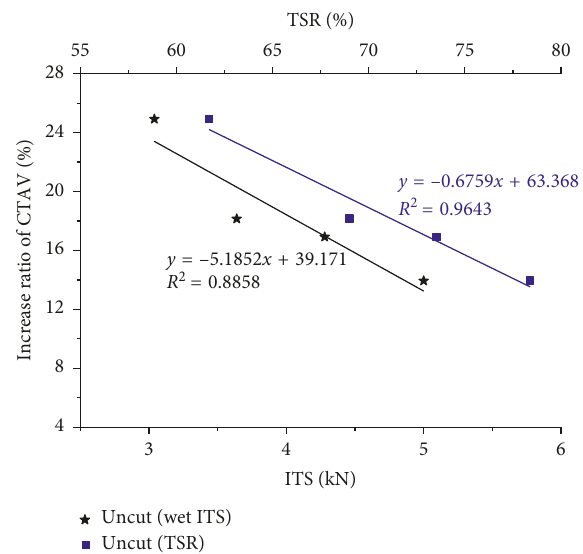
Figure 11: ITS/TSR versus increase ratios of CTAV of the RH- WMA.